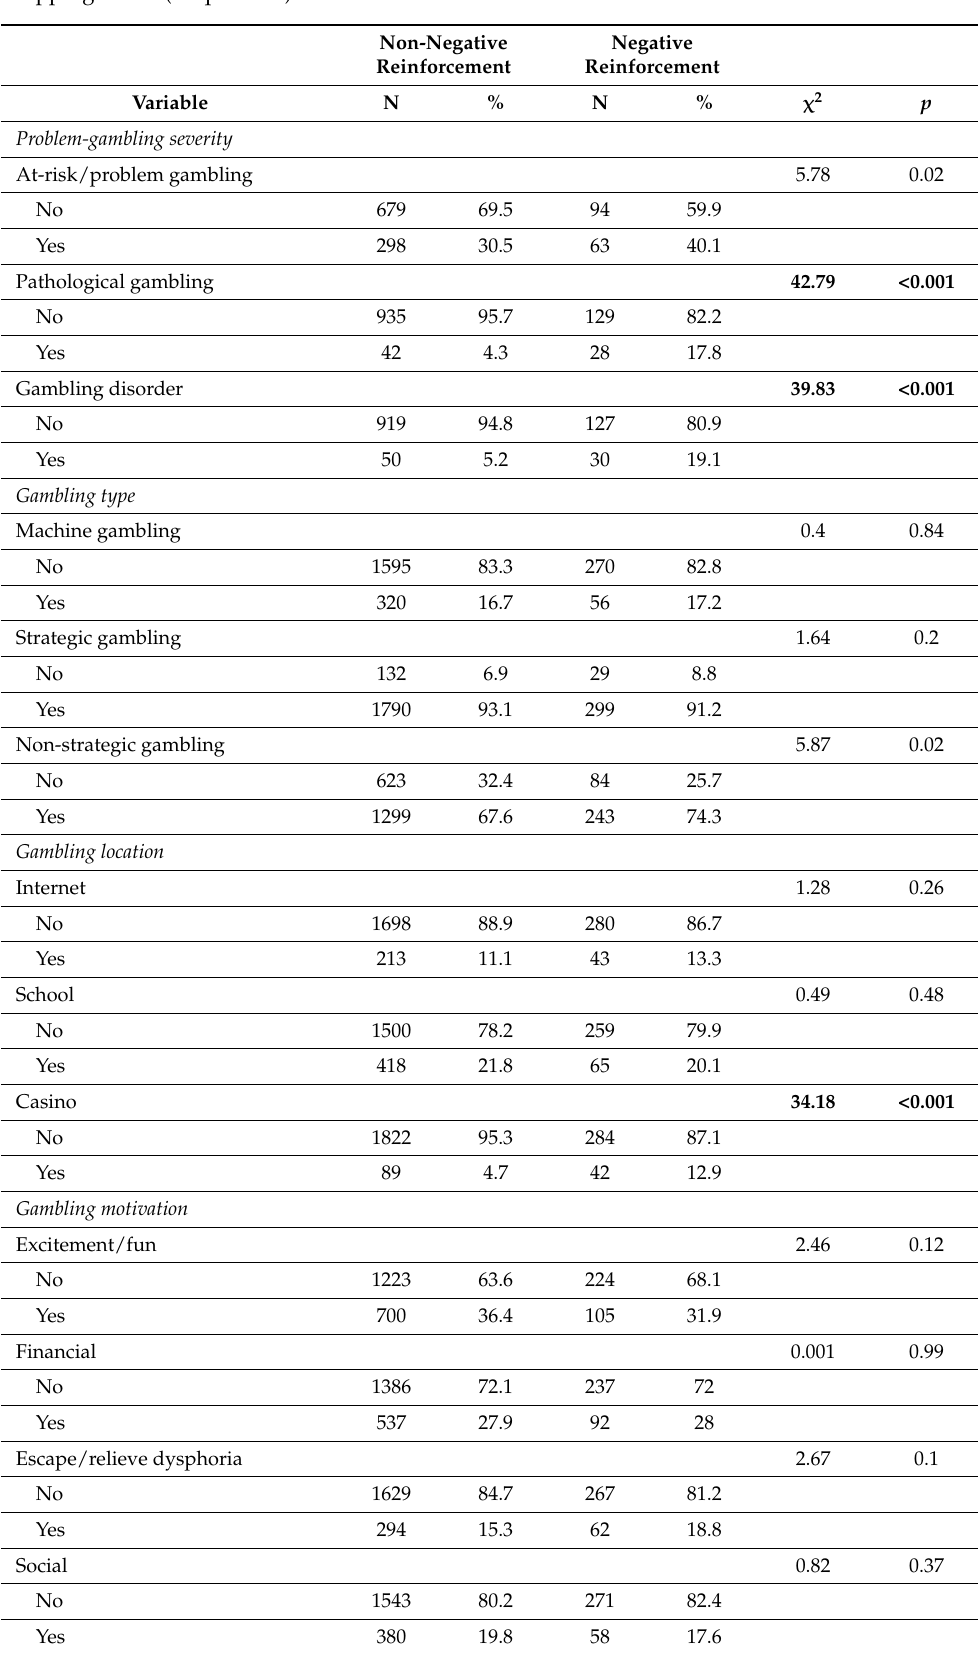
Table A2. Problem-gambling severity/gambling behaviors stratified by negative-reinforcement- shopping status